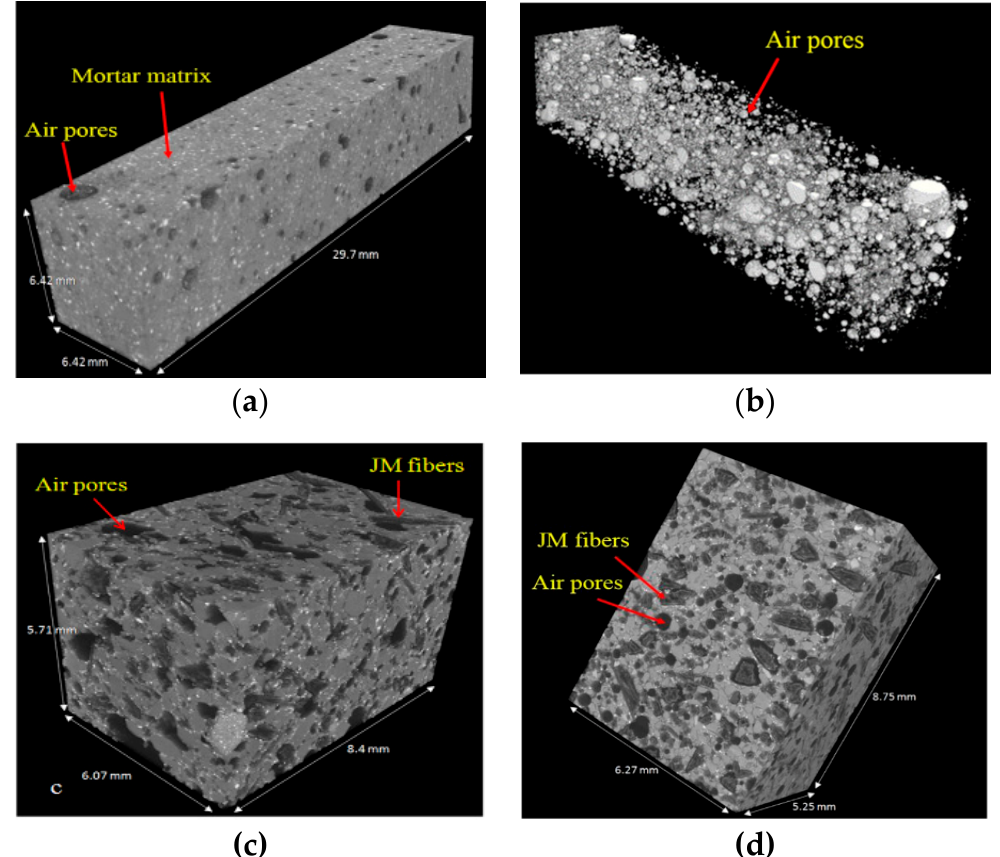
Figure 5. 3D-micro computed tomography (µCT) images of composites: ( a ) Reference mortar (Resolution 1 voxel = 22 µm); ( b ) pores in the reference mortar; ( c ) composite with 5 wt% of fibers ((Resolution 1 voxel = 7 µm); ( d ) composite with 10 wt% of fibers (resolution 1voxel = 7 µm ).